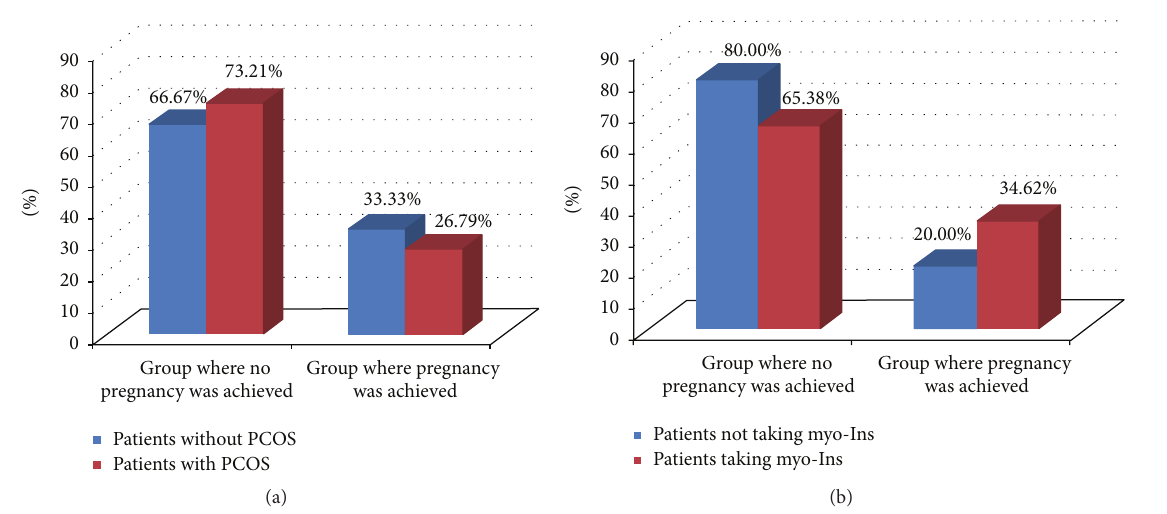
Figure 1: Pregnancy percentage. (a) Percentage layout of pregnancies in the group with PCOS and without PCOS. Chi 2 = 1.107, df = 1 , and 𝑝 = 0.293 ; (b) percentage layout of pregnancies in the group with PCOS among patients taking myoinositol and patients who were not taking this preparation (Chi 2 = 3.034, df = 1 , 𝑝 = 0.081